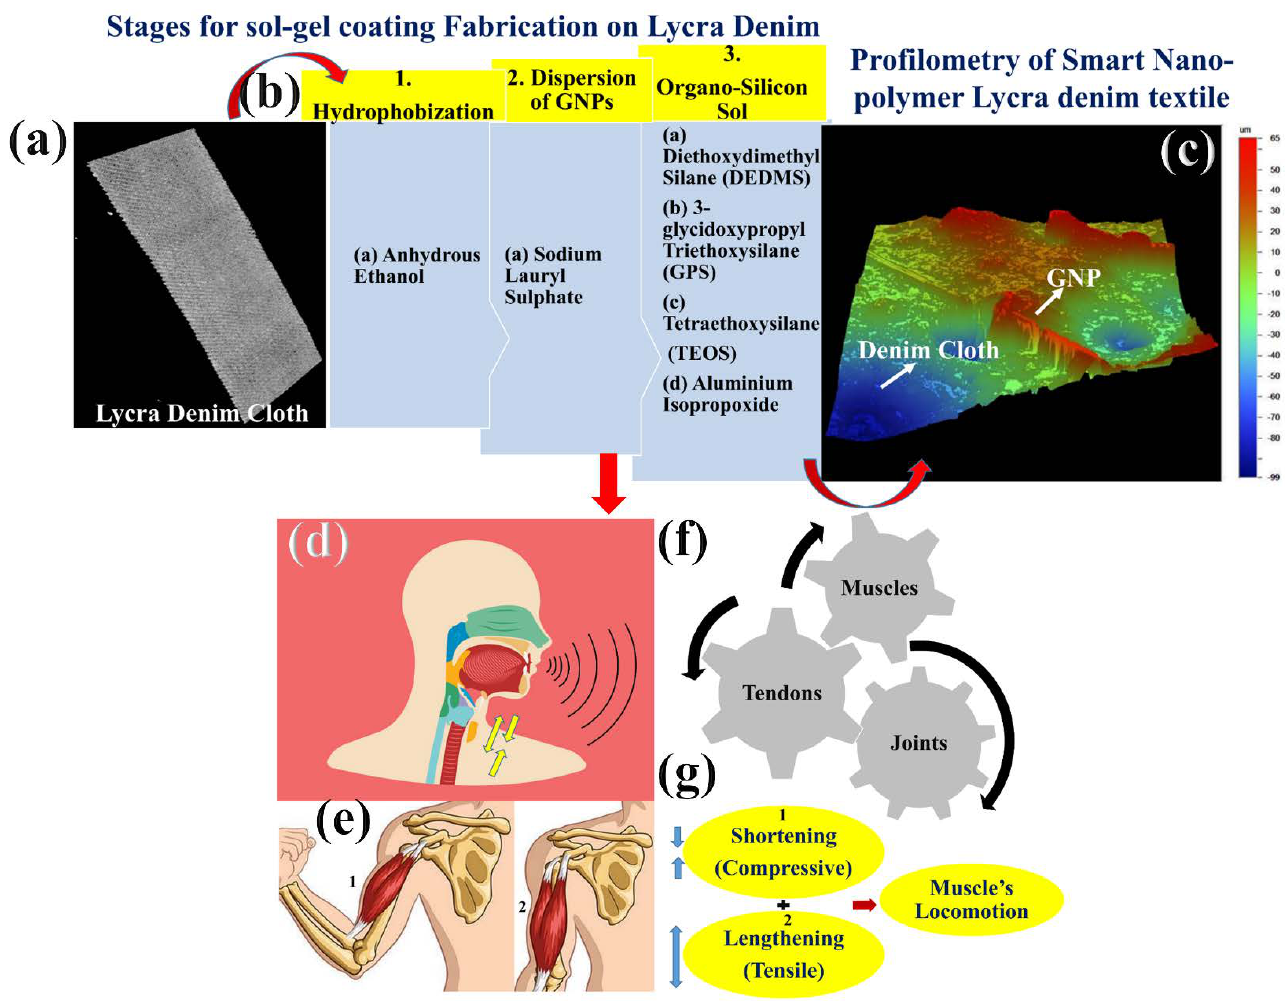
Figure 9. Fabrication of smart Lycra denim textile cloth and profilometry study: ( a , b ) computed tomography of Lycra denim cloth and b chemicals used for sol–gel coating fabrication upon Lycra denim textile; ( c ) profilometry used for measurement of thickness of coating; ( d , e ) sensor location for wrapping around neck and bicep zone; ( f , g ) schematic for human body locomotion with muscles, tendons, and joints during compressive and tensile action.